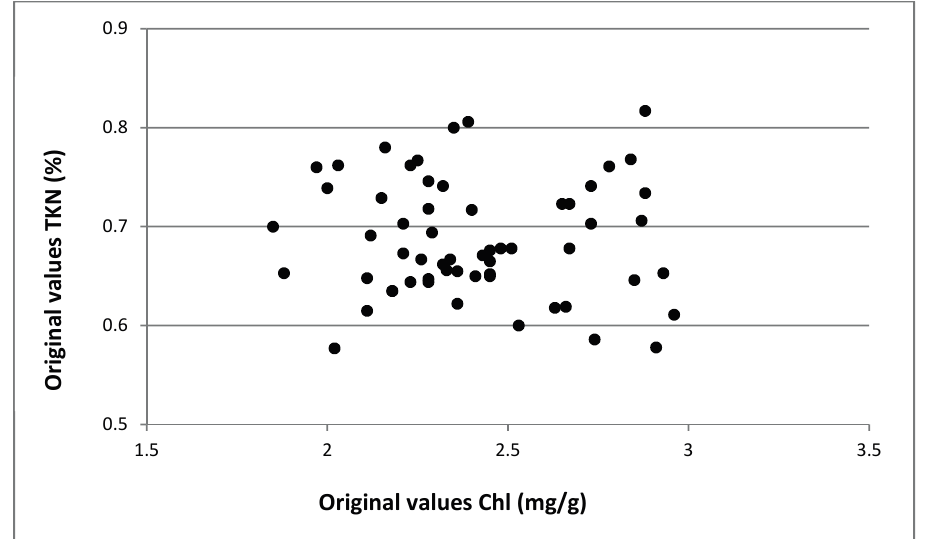
Figure 4. Relationship between total chlorophyll and TKN content in fresh apple leaves (data obtained through chemical